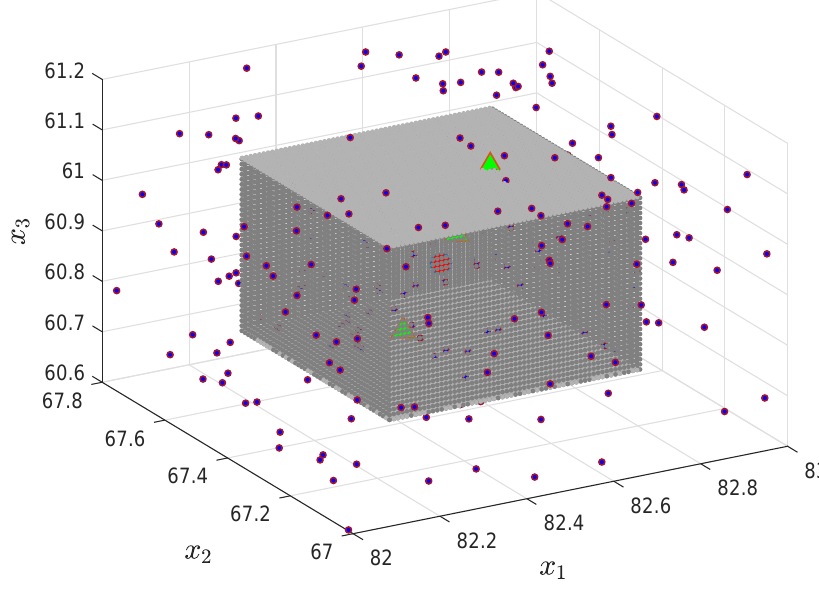
Figure 1. Equilibrium